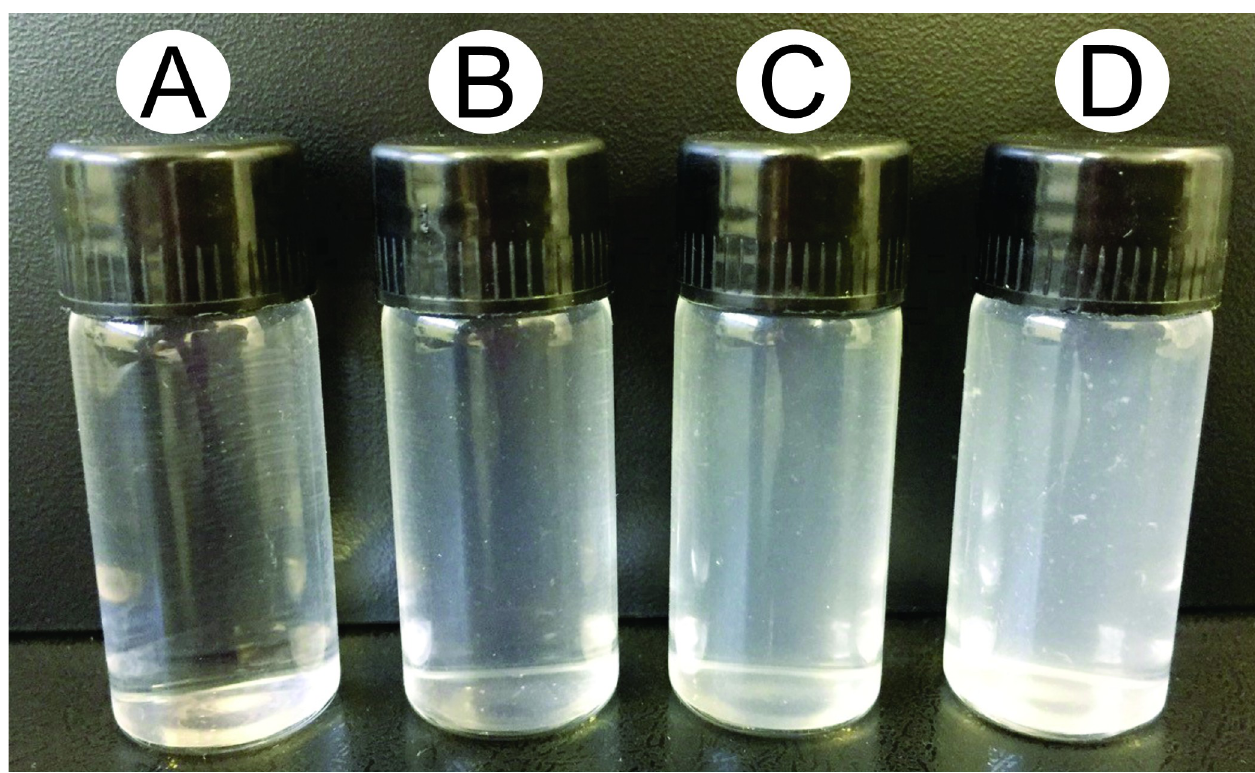
Fig 3. Turbidity observed in the different hemolymph samples of larvae in the fifth instar extracted using the different proposed extraction techniques. (A) Hemolymph extraction using ophthalmic scissors; (B) Hemolymph extraction using a hypodermic syringe; (C) Hemolymph extraction using a 30G needle; (D) Hemolymph extraction using fine-tipped forceps. The four different samples were diluted 2,500x for viewing under the light microscope.